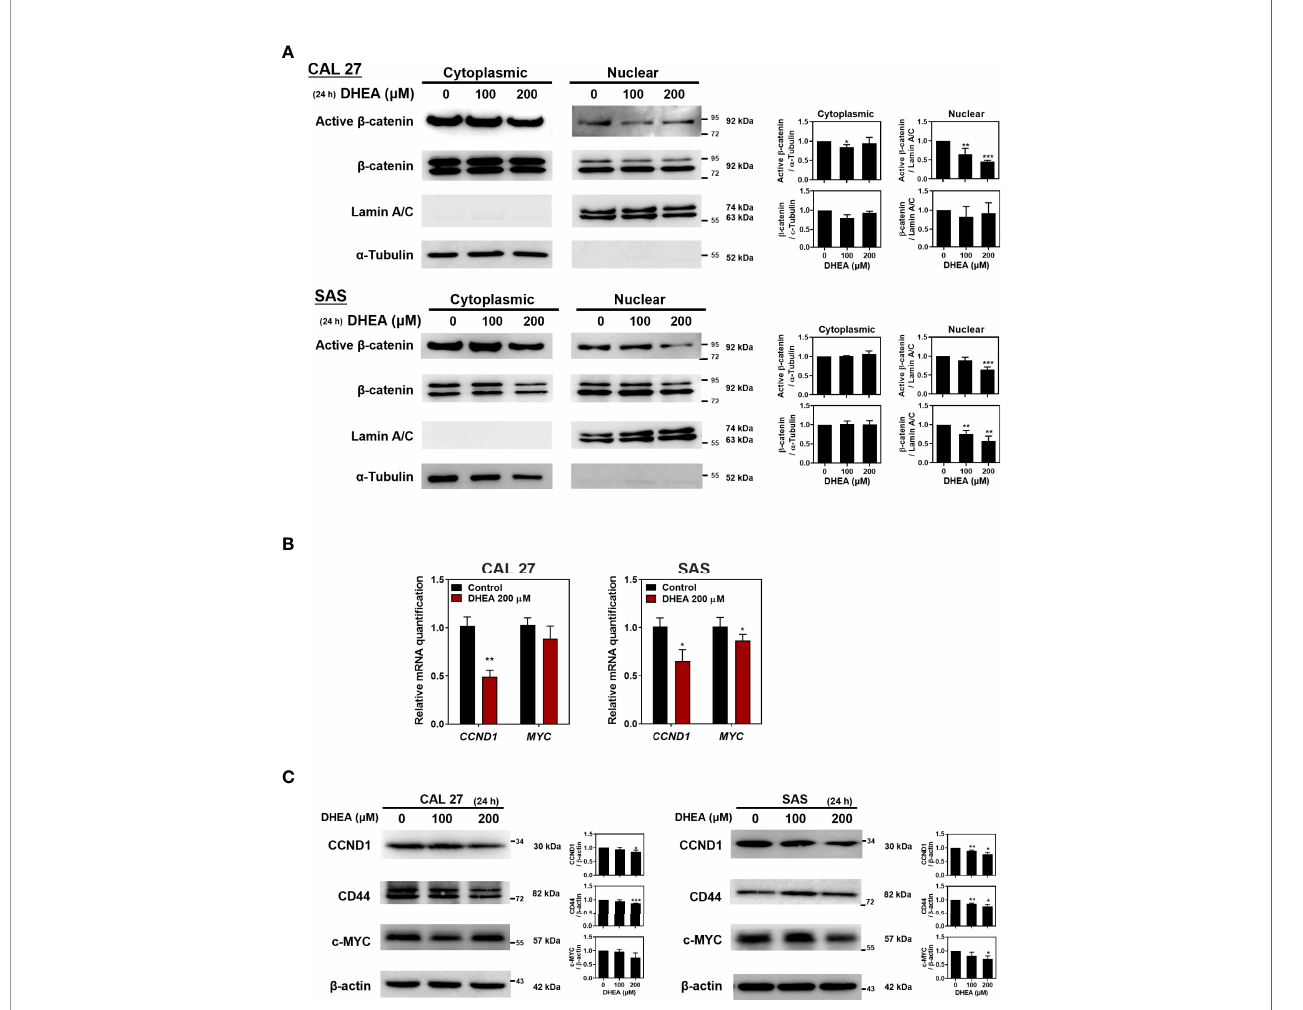
FIGURE 2 | DHEA downregulated WNT pathway in HNSCC cells. (A) Western blotting with nuclear extracts showing the effect of treatment with 200 m M DHEA for 24 h on active b -catenin in CAL 27 and SAS cells. a -tubulin was used as a cytoplasmic control; lamin A/C was used as a nuclear fraction control. Active b -catenin was normalized to a -tubulin or lamin A/C. (B, C) RT-qPCR (B) , and western blotting (C) showing effect of DHEA on mRNA and protein expression of downstream genes of the WNT pathway in CAL 27 and SAS cells. Left , representative western blots of three independent experiments are shown. Right , bar charts represent the quantitation of three independent experiments. Data represent mean ± SD derived from three independent experiments. * p < 0.05; ** p < 0.01; *** p < 0.001, compared to control (1% DMSO only) using t-test